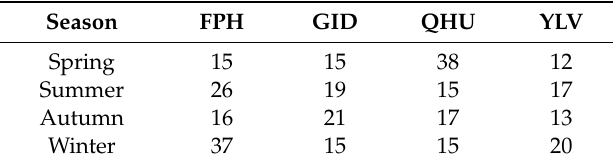
Table 1. Number of samples at each site per season